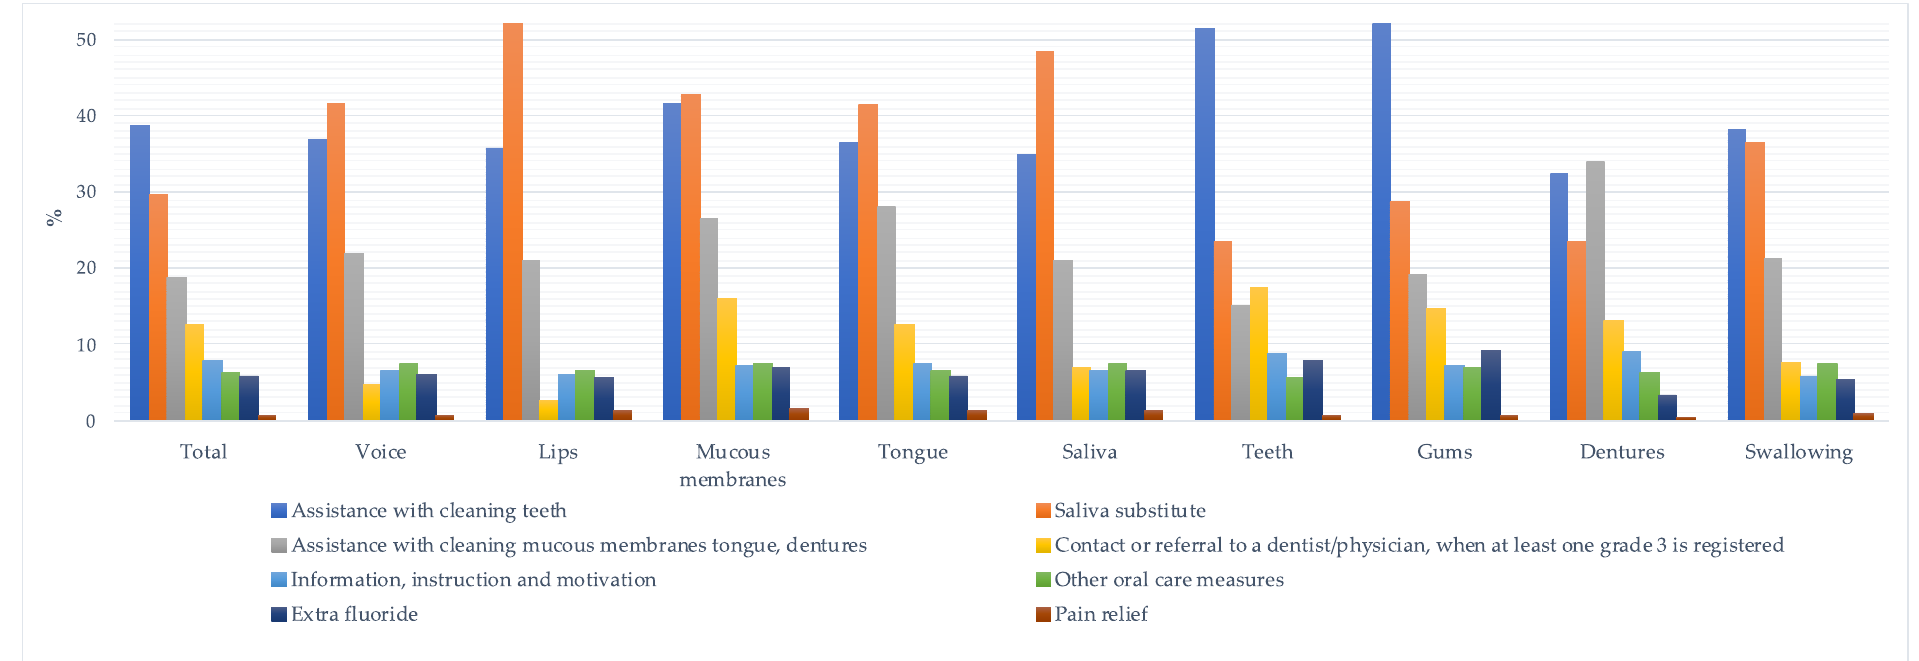
Figure 2. Percentages of registered actions if oral health problems (at least one grade 2 and/or grade 3) were detected at the first ROAG-J assessment, in total and for each ROAG-J item, except for the registered action “Contact or referral to a dentist/physician”, when “severe risk” (at least one grade 3) was detected.